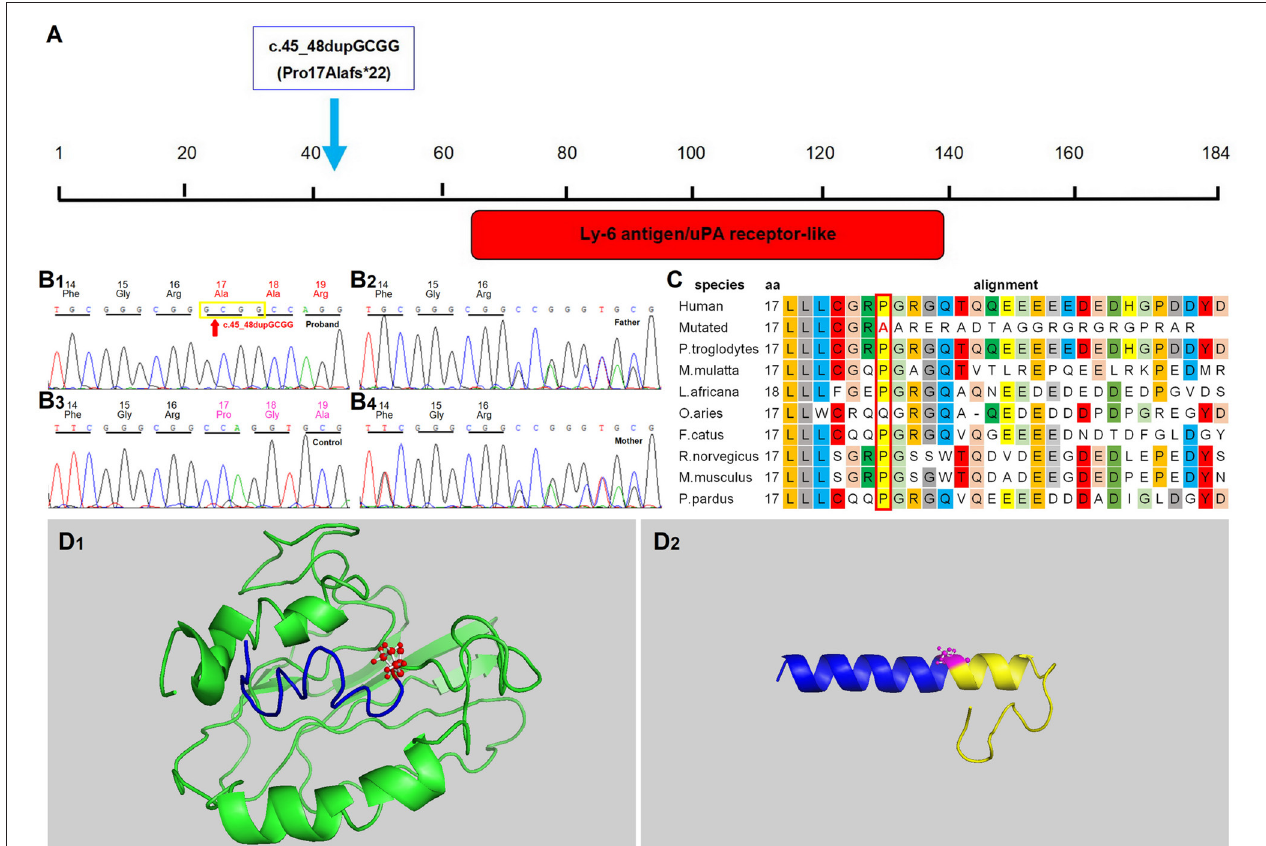
FIGURE 2 | Identification of the variant in GPIHBP 1 gene. (A) Graphical view of the protein domain and structure of GPIHBP 1. The red box stands for the Ly-6 antigen/uPA receptor-like domain (IPR016054). The homozygous variant c.45_48dupGCGG (p.Pro17Alafs*22) is marked by wathet blue arrow. (B) Sequence chromatograms of the GPIHBP 1 variant. (B1–B4) indicates the variant sequences of c.45_48dupGCGG in the proband, his father, mother and normal controls, respectively. The duplication variant site is indicated by red arrow. (C) BLAST comparison of the sequence around amino acids 17 in orthologs of GPIHBP1 among various species. The block and colored characters represent highly conserved amino acids among these species, while the white shading stands for inconsistent residues. (D) Structural difference between wild-type and C-terminal frameshift GPIHBP1 proteins. Efforts were made to predict the functions of the mutant protein and the wild-type (full-length) GPIHBP1. The full length wild-type protein is exhibited in the left panel (D1) , and the mutant protein (p.Pro17Alafs*22) in the right panel (D2) . As shown in the mutant GPIHBP1 proteins (D2) model, the frameshift originated from p.Pro17Alafs*22 variant is highlighted in yellow, corresponding to the wild-type portion depicted in green (D1) . Meanwhile, the consistent part of the N-terminus of the wild-type and the mutant protein is show in blue. It can be seen that the variant compromises the original structure and integrity of the GPIHBP1